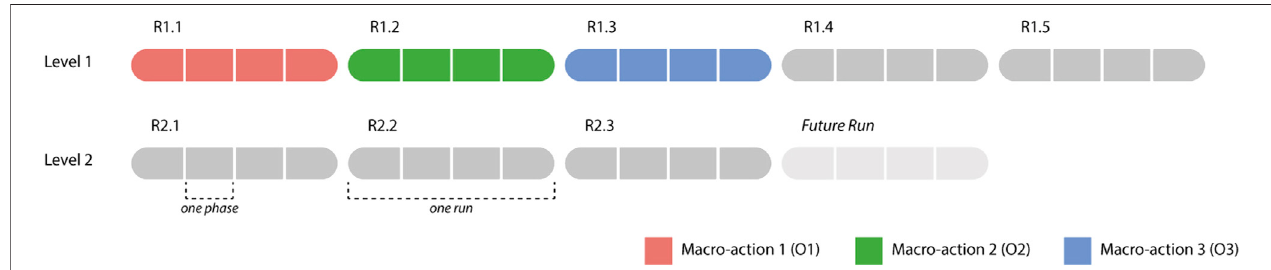
FIGURE 6 | An overview of the representation of the learning problem embedded in the experiment. It shows the different runs that a participant went through (5 runsforlevel1,3runsforlevel2),aswellashowtherunswereseparatedinto4phasesde fi nedbythePhaseVariables.ThecolorsshowhowinR1.1,R1.2andR1.3,the robot usually used O1 — picking up all , O2 — passive large rocks and O3 — breaking respectively in each phase. From R1.4 onwards, the robot would choose a Macro- action based on the learned Q-values. The Future Run portrays the behavior that the robot would engage in if there were another run, based on the Q-values after